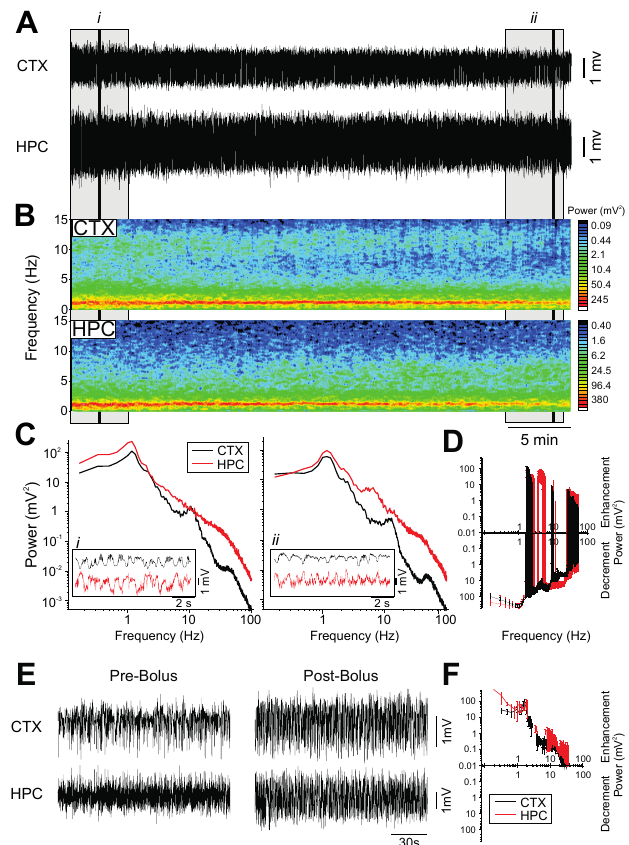
Figure 2. Global slow-oscillatory activity under ketamine-xylazine anesthesia. ( A ): Continuous, 40 min duration cortical (CTX) and hippocampal (HPC) EEG traces. 5 min (grey box) and 10 s (black line) samples from the beginning (i) and end (ii) of the 40 min recording are further analyzed in C. ( B ): Spectrograms of CTX and HPC traces from A. ( C ): Power spectra of a 5 min selection (grey box) from the EEG traces in A, with an inset of a 10 s raw CTX and HPC EEG trace (black line) from the beginning of A (left panel, i) and end of A (right panel, ii). ( D ): The average difference in spectral power over a 40 min metabolism period, plotted using 2 min samples pre- and post-metabolism to denote the average increment or decrement of power ( n = 3). ( E ): Pre-bolus: A 2 min sample of CTX and HPC traces during a surgical plane of ketamine-xylazine anesthesia. Post - bolus : A 2 min sample of CTX and HPC traces following a bolus infusion of ketamine-xylazine (16.6 ± 1.9 mg/kg and 1.5 ± 0.1 mg/kg; n = 5). ( F ): The average difference in spectral power following bolus infusion, plotted using 2 min samples pre- and post-bolus to denote average increment or decrement of power ( n =